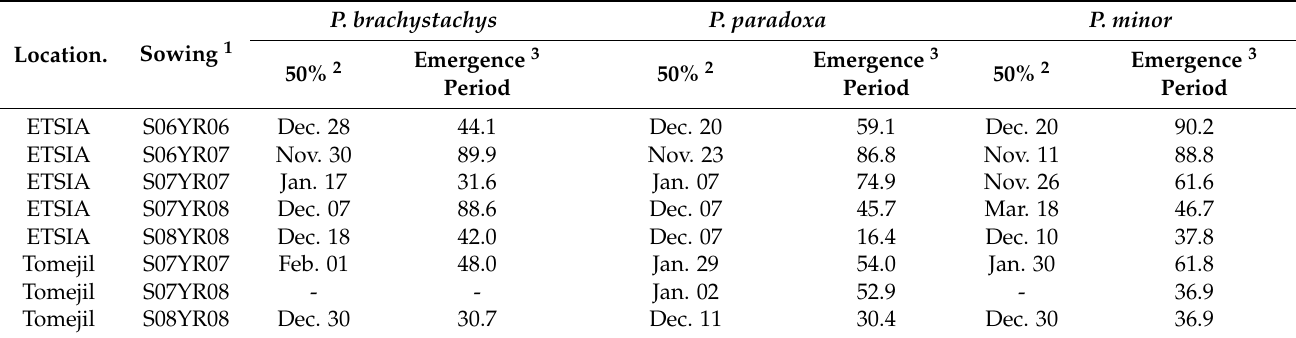
Table 5. Emergence periods and dates when 50% emergence was reached in each of the three Phalaris species.